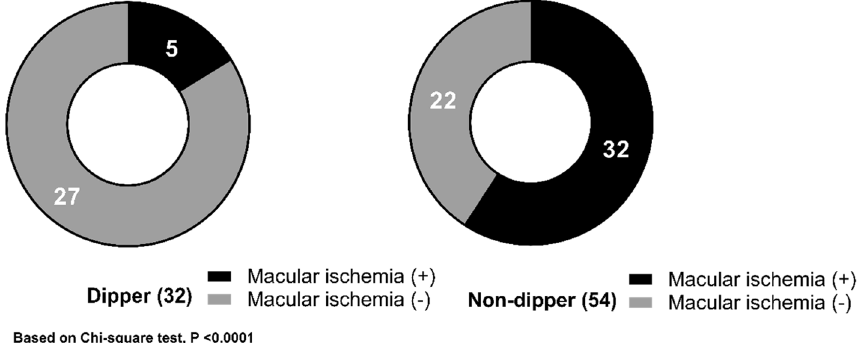
Figure 1. The proportion of macular ischemia is compared between the dipper and non-dipper groups. The non-dipper group demonstrates a high prevalence of macular